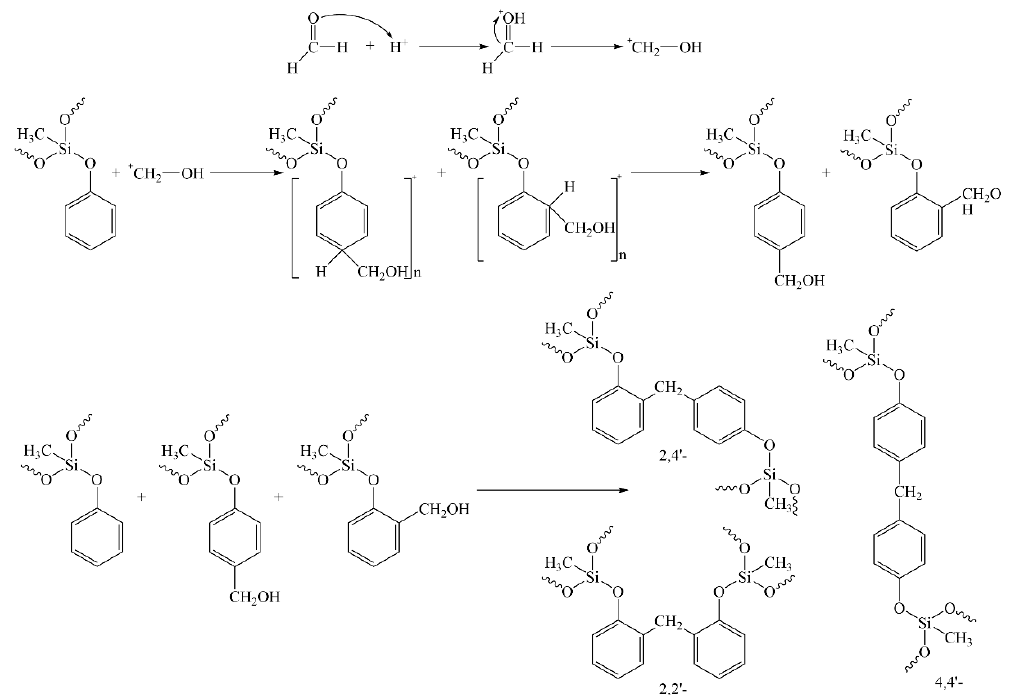
Figure 2. Reaction of methyl-trimethoxy-silane intermediates with POM.